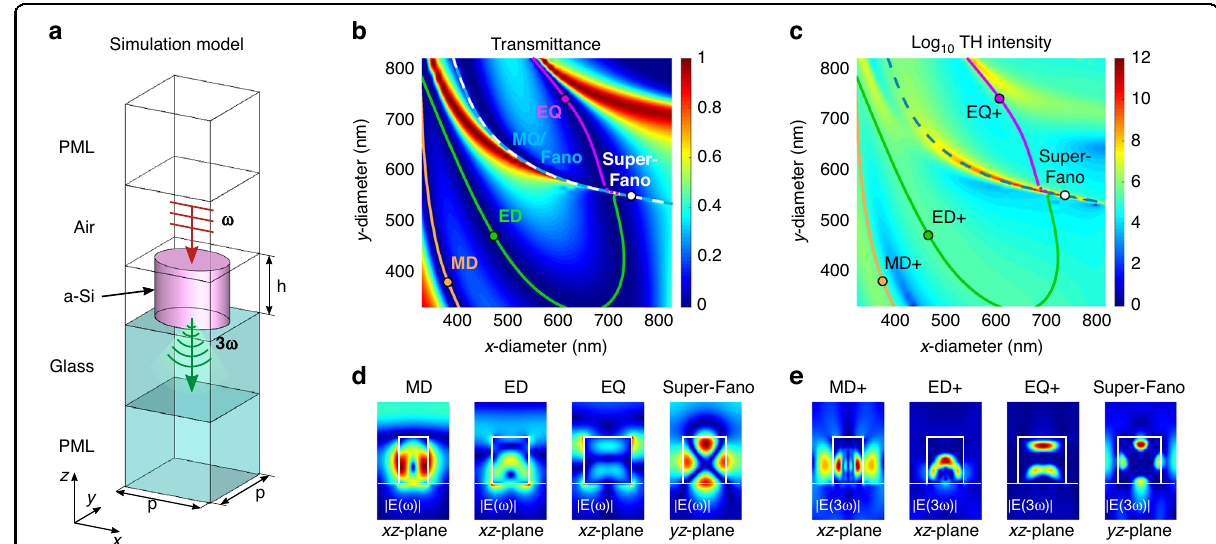
Fig. 2 Numerical analysis. a Simulation model of a unit cell for the in fi nitely periodic metasurface consisting of a-Si resonators. b Calculated transmittance and c TH intensity (log scale) maps as a function of elliptical diameters d x and d y of the resonator. The colored curves plotted in both maps highlight the paths of the FF mode resonances ( b ). d , e Calculated electric near- fi eld plots of modes for different resonators with diameters indicated by points in the maps at ( d ) pump 1560 nm and (e) TH 520 nm wavelengths. The periodicity of the unit cell and the resonator height are p = 916.7 nm and h = 590 nm, respectively. The maximum of the generated TH is indicated by the dot with label Super-Fano in both maps for the resonator with diameters d x = 740 nm and d y = 550